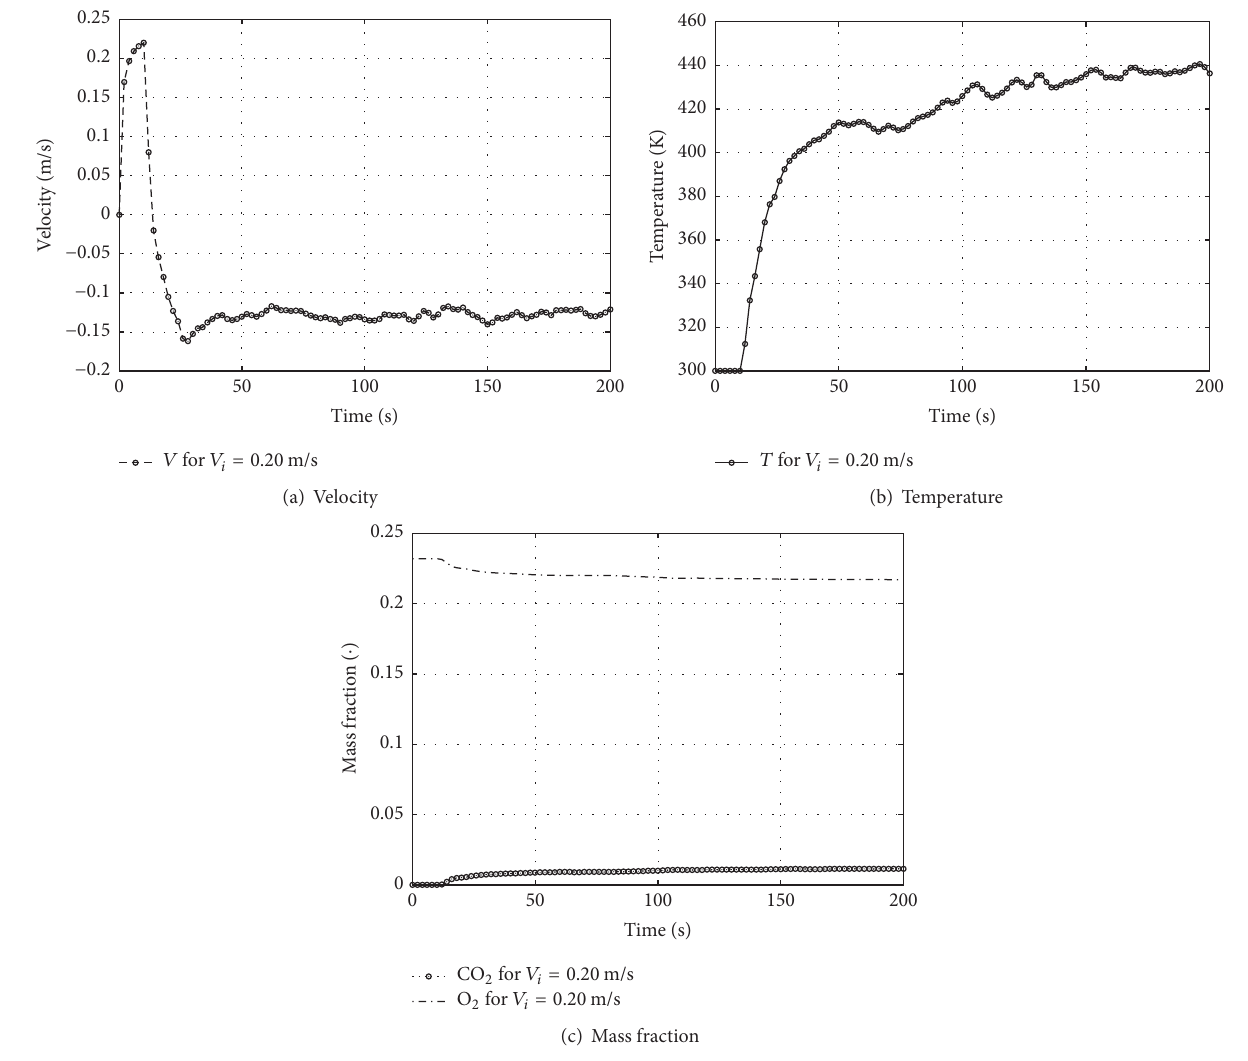
Figure 10: Upstream conditions for 𝑉 𝑖 = 0.20